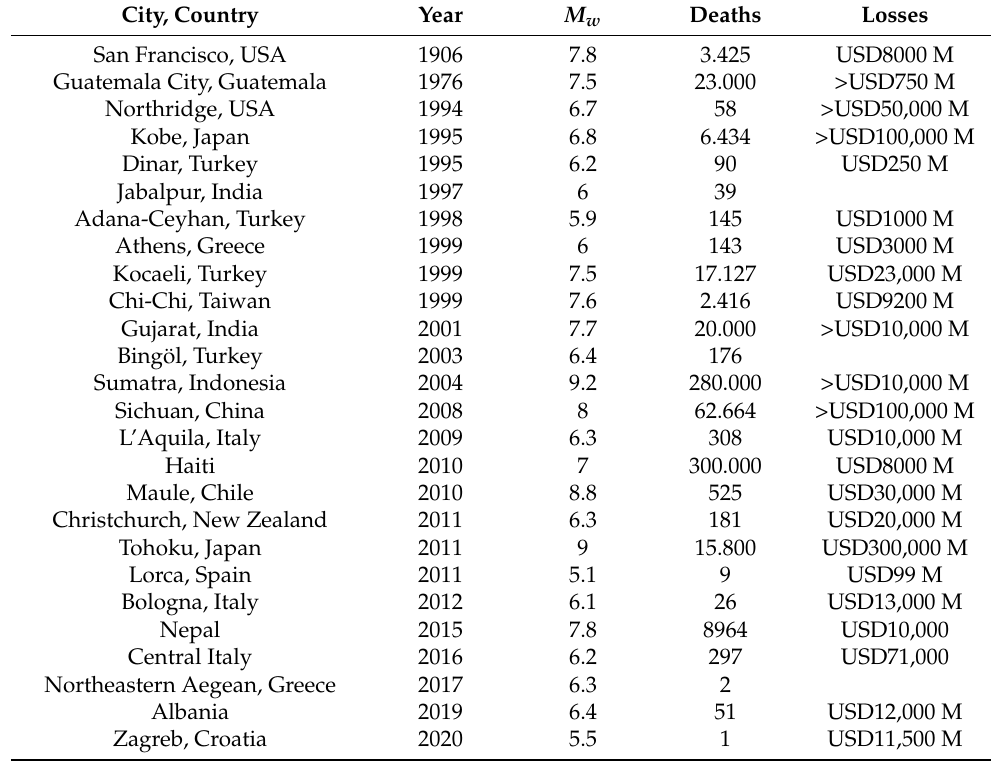
Table 4. Some earthquake occurrences in the